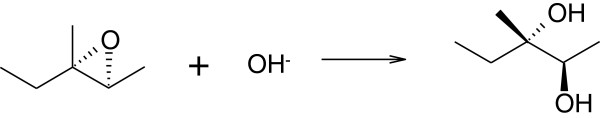
Long RInChIKey, versions A and B. A. Long RInChIKey = aSA-EFKSL-ZISUZIXPPXXNPC-WDSKDSIN-N-XLYOFNOQVPJJNP-UHFFFAOY-M--RLWWHEFTJSHFRN-RITPCOAN-N. B. Long RInChIKey = aSA-FEANN-ZISUZIXPPXXNPC-WDSKDSIN-N-XLYOFNOQVPJJNP-UHFFFAOY-M--RLWWHEFTJSHFRN-RITPCOAN-N.